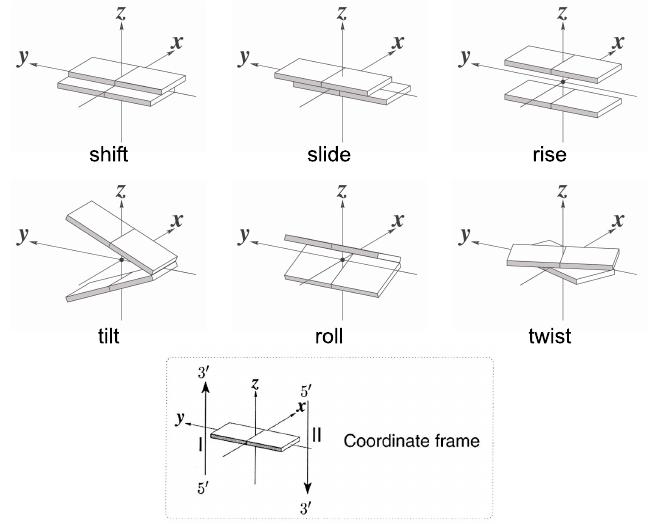
Figure 8. Schematic diagram of base-step rigid coordinates. For illustration purposes, helical twist is the same as twist and helical rise is the same as rise